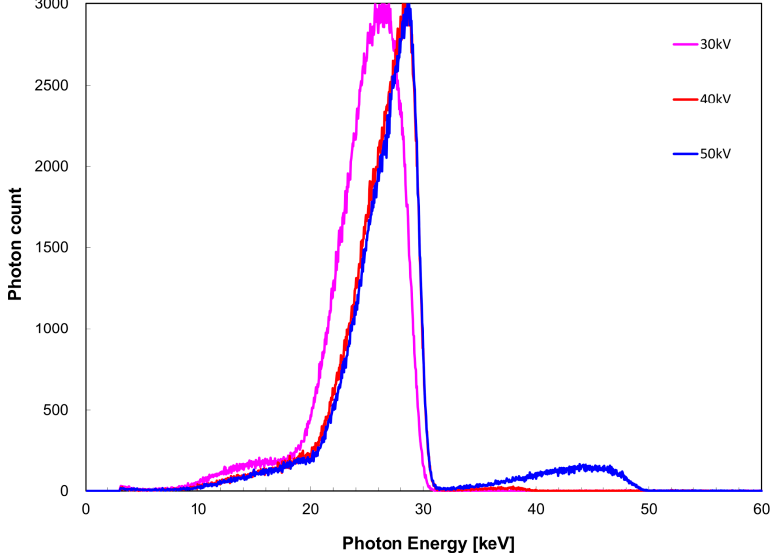
Figure 3. Tube voltage dependence of X-ray spectrum when the tin filter was used.